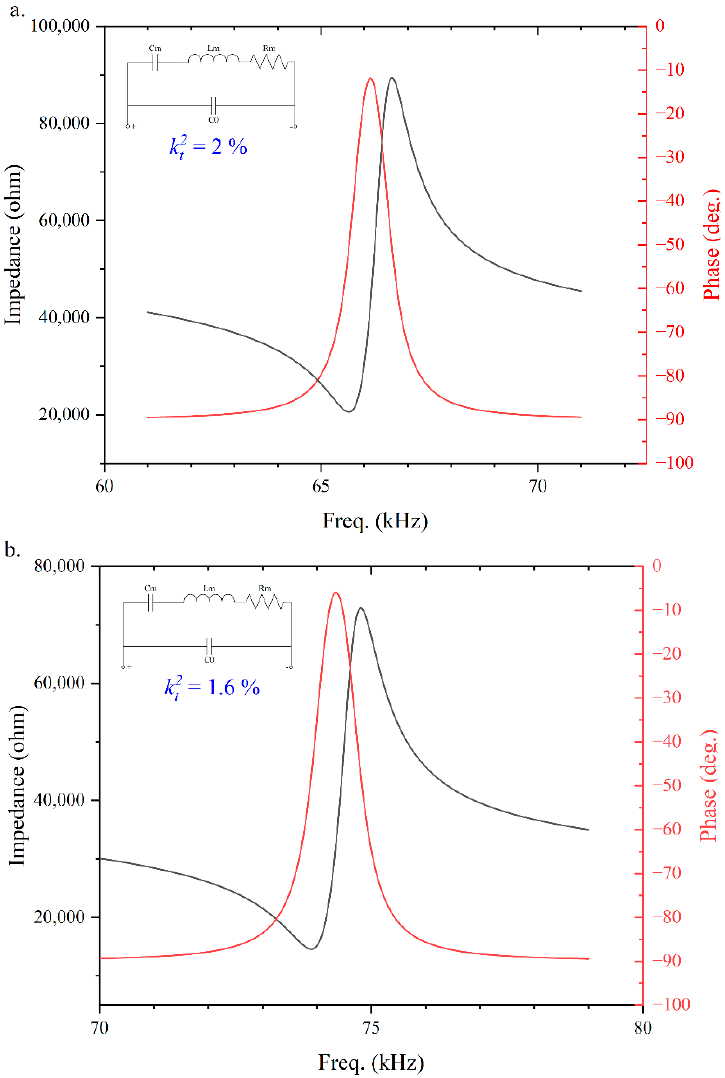
Figure 4. Electrical impedance measurement of ( a ) The designed PMUT with the resonant frequency = 2%; ( b ) The control PMUT with the resonant frequency of f of f 0 = 66 kHz, k 2 t = k 2 t